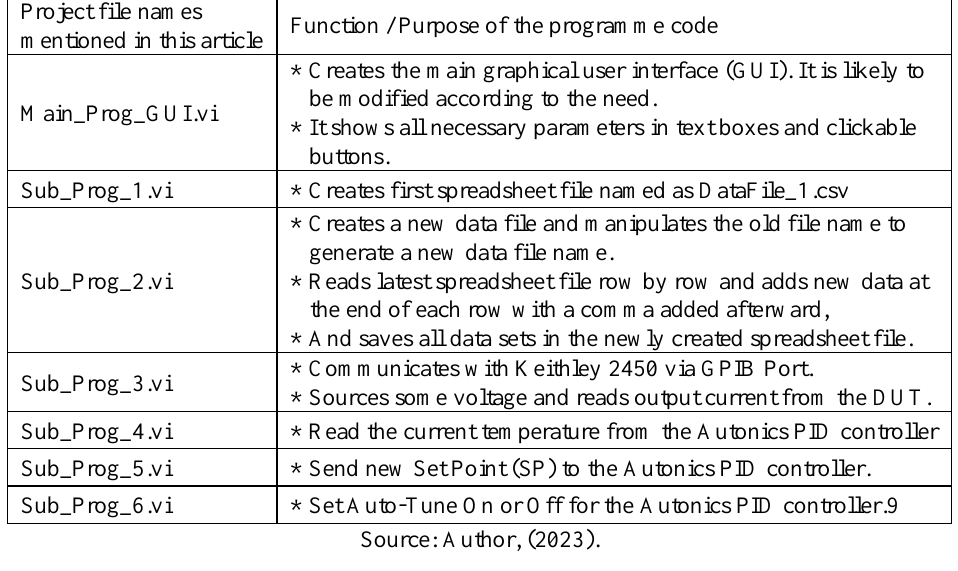
Table 2: List of project files and the functions performed by them.